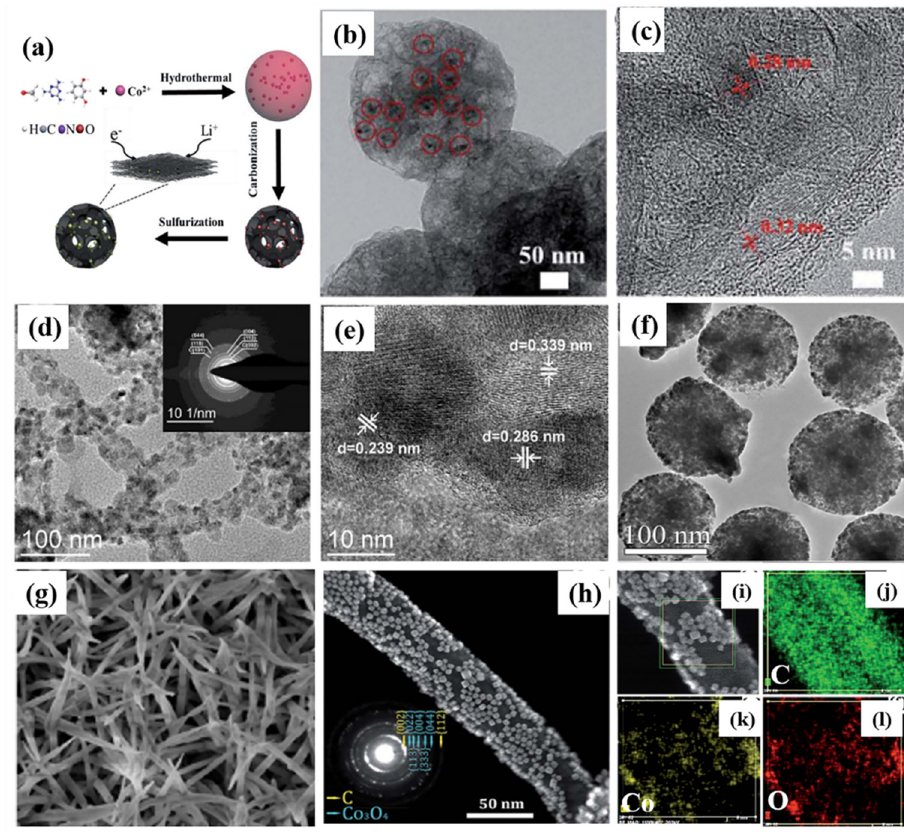
Figure 4. Preparation methods and morphology characterization of cobalt-based composites. ( a ) Schematic illustration of the preparation of ( b ) TEM and ( c ) HRTEM images of the CoS 2 -in-wall-N-doped carbon spheres (NCSs) [58]. ( d ) TEM image, SAED pattern (inset) and ( e ) HRTEM image of CNTs@CuCo 2 S 4 [59]. ( f ) Low-magnification TEM image of CoSe@100CSs [60]. ( g ) SEM image of CoP nanorod arrays [61]. ( h ) Low and ( i ) high-magnification SEM images and ( i – k ) elemental mapping images of Co 3 O 4 / CNT nanocomposites